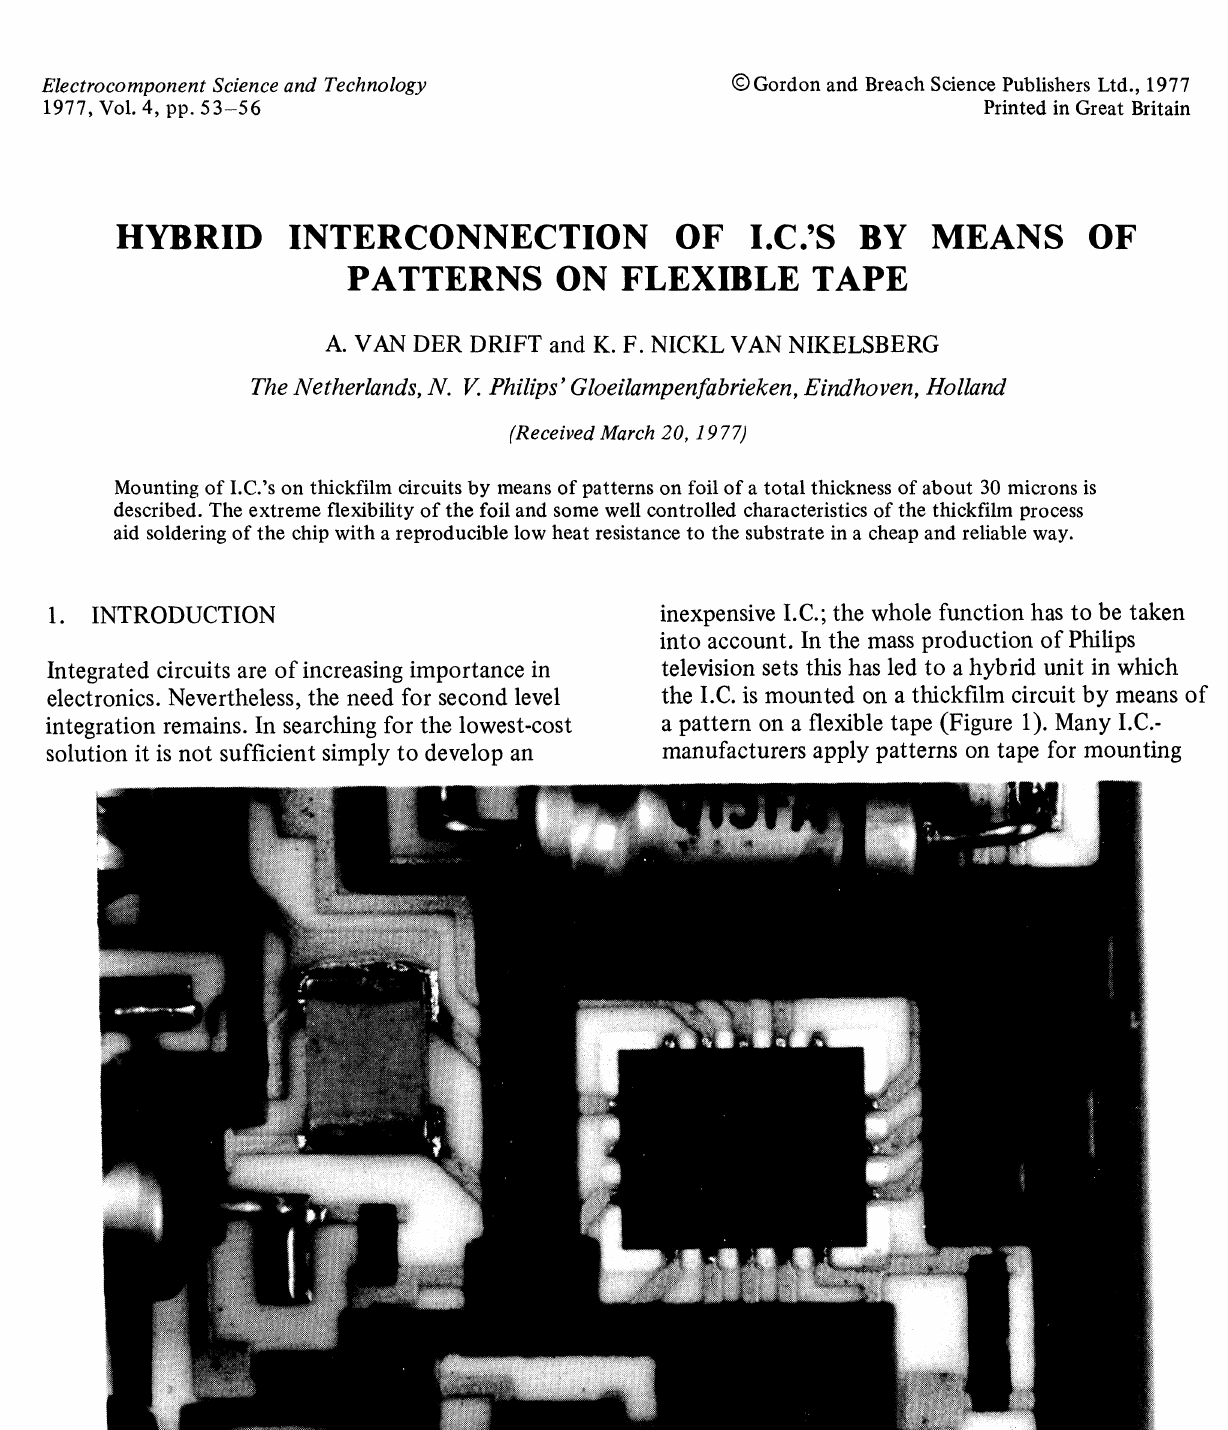
FIGURE 1 Photograph of a part of a thickfilm unit with an I.C.-on-tape mounted onto it.